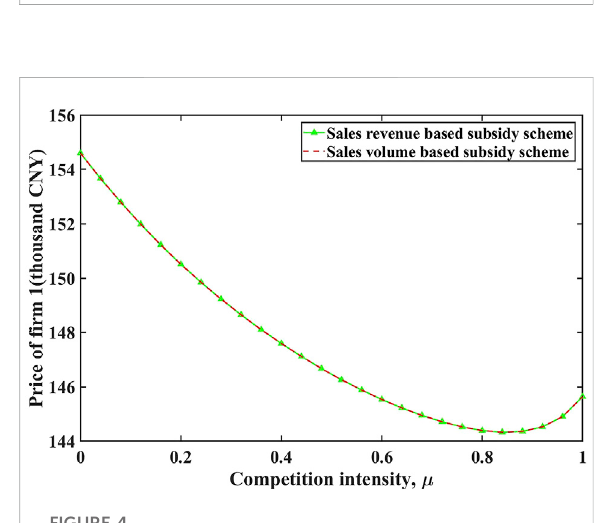
FIGURE 4 Comparison of fi rm 1 ’ s price under two different subsidy